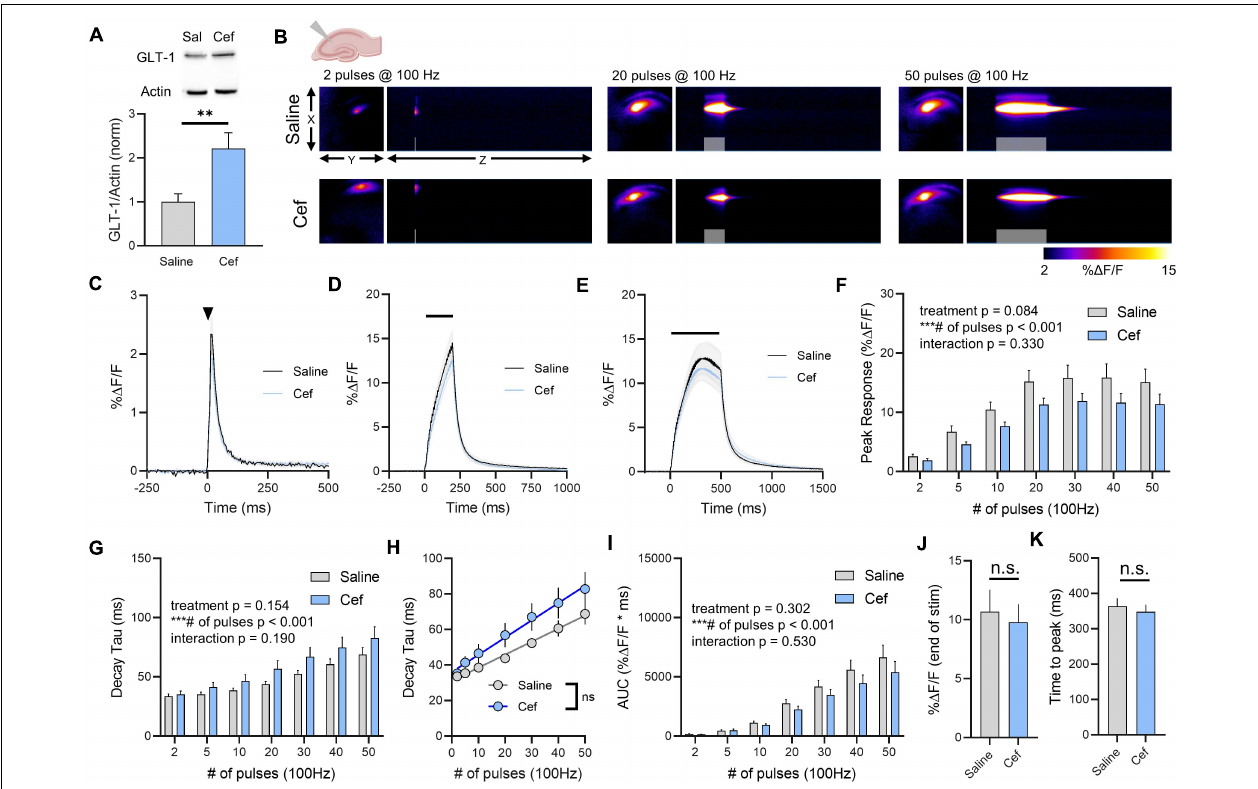
FIGURE 1 | The effect of ceftriaxone on glutamate dynamics in the hippocampus. (A) GLT-1 expression in hippocampal tissue from saline and ceftriaxone (Cef)-treated mice. (B) Representative images depicting the iGluSnFR response evoked by 2 (left), 20 (middle), and 50 (right) pulses of electrical stimulation at 100 Hz in saline- (top) and Cef-treated (bottom) mice. X–Y images (2048 × 2048 µ m) depict the maximal projection image of the iGluSnFR response, while the X–Z image (2048 µ m vertically x 1945 ms horizontally) depicts the iGluSnFR response over time (z-axis). Gray shading indicates the onset and duration of electrical stimulation at 100 Hz. (C–E) Mean ( ± S.E.M in gray) iGluSnFR responses to 2 (C) , 20 (D) , and 50 (E) pulses at 100 Hz in saline- and Cef-treated mice. Electrical stimulation is denoted by the arrowhead in (C) and the horizontal lines in (D) and (E) . (F) Mean ( ± S.E.M) iGluSnFR response peaks. (G) Mean ( ± S.E.M) iGluSnFR decay tau values. (H) Linear regression to assess the magnitude of the activity-dependent increase in iGluSnFR decay tau. (I) Mean ( ± S.E.M) iGluSnFR area under the curve (AUC). (J) Mean ( ± S.E.M) of the iGluSnFR response size (% (cid:49) F/F) at the termination of the 50-pulse stimulation paradigm (50 pulses at 100 Hz). (K) Mean ( ± S.E.M) of the time required for the iGluSnFR response to reach a peak during the 50-pulse stimulation paradigm. ∗∗ p < 0.01, ∗∗∗ p < 0.001. n.s. not significant. Brain slice schematic in (B) was created using